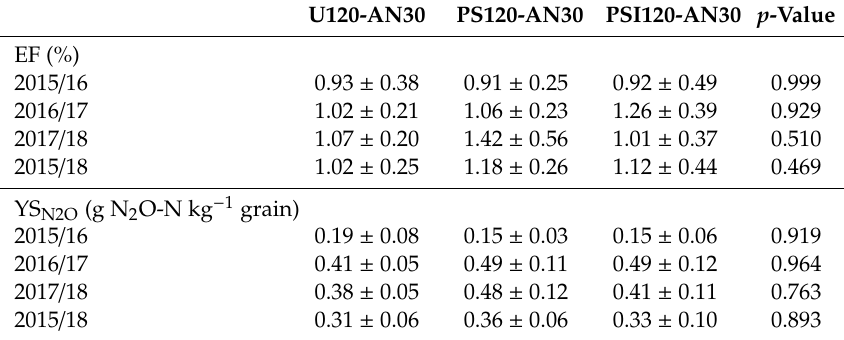
Table 6. EF (%) and YS N2O emission (g N 2 O-N kg − 1 grain) (mean ± standard error; n = 4) in the di ff erent fertilized treatments (U120-AN30, PS120-AN30, and PSI120-AN30) for the three years (2015 / 16, 2016 / 17, and 2017 / 18) and the whole experiment (2015 / 18). The data include the crop period (sowing to harvest) and the intercrop period (harvest to the following crop